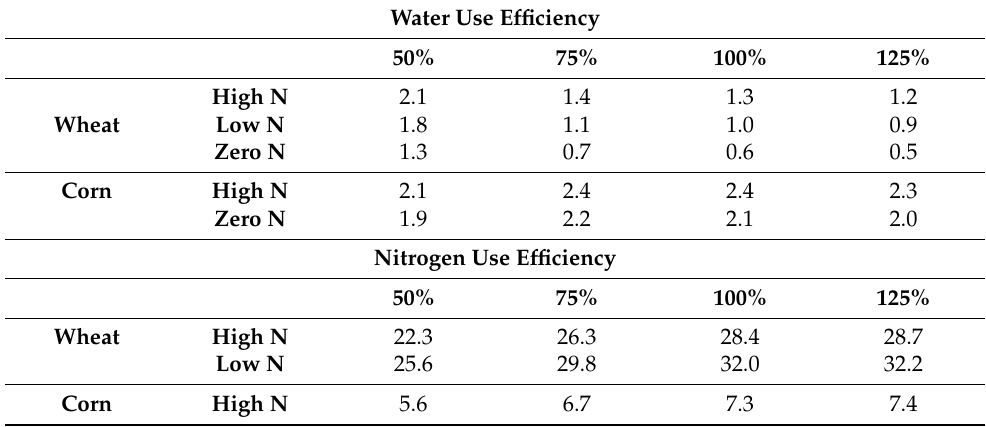
Table 5. Simulated water use efficiency (kg/m 3 ) and nitrogen use efficiency for wheat and corn